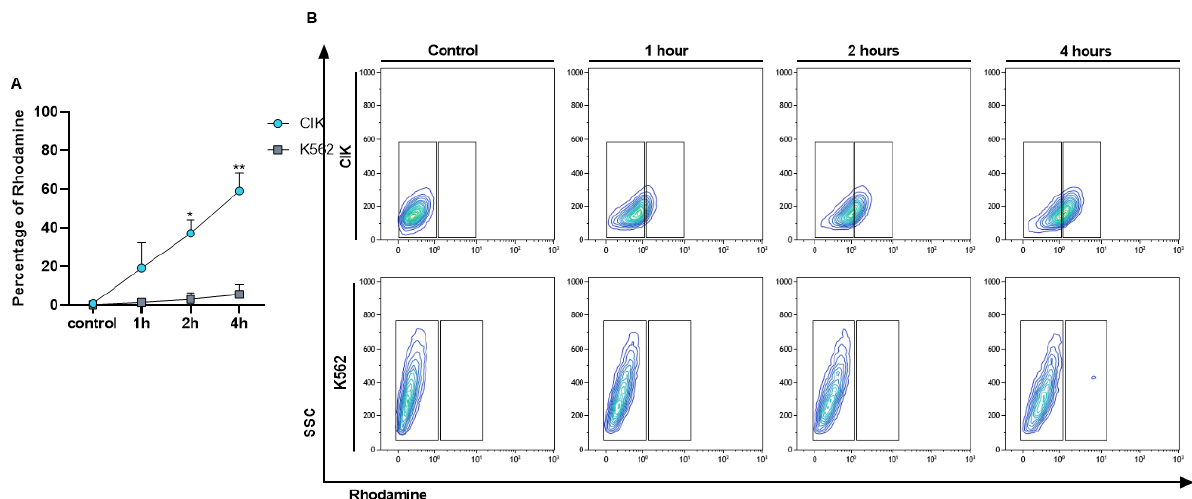
Figure 3. Kinetic binding assay. Interaction of IL-Rho after 1 h, 2 h, 4 h of the treatment with CD26+ CIK cells and CD26 − K562 cells was measured by flow cytometry. The Rhodamine percentage in positive and negative cells for CD26 is displayed in ( A ) and flow cytometry graph of the kinetic binding assay is shown in ( B ). (* p < 0.05, and ** p < 0.01).